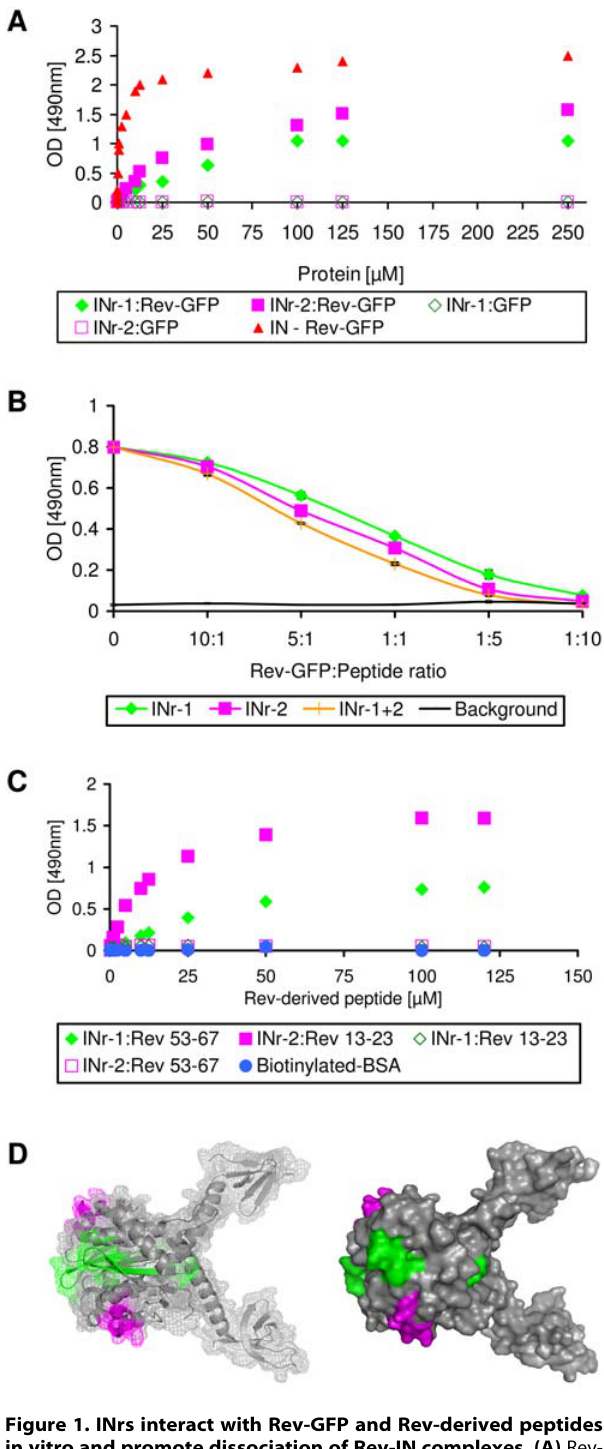
Figure 1. INrs interact with Rev-GFP and Rev-derived peptides in vitro and promote dissociation of Rev-IN complexes. (A) Rev- GFP or GFP alone were incubated in ELISA plates coated with either INr- 1 (Green full and empty diamond respectively) or INr-2 (Magenta full and empty square respectively) and binding was determined as described in Materials and Methods. IN-Rev-GFP interaction was used as positive control (Red triangle) (B) The IN protein was first bound to the ELISA plate and then incubated with Rev-GFP to obtain a Rev-IN complex. The complex was then incubated with either one or both of the INr peptides at the designated Rev-GFP:peptide ratio. Wells were then washed and the amount of bound Rev-GFP was determined by mouse anti-GFP antibody and secondary rabbit anti-mouse